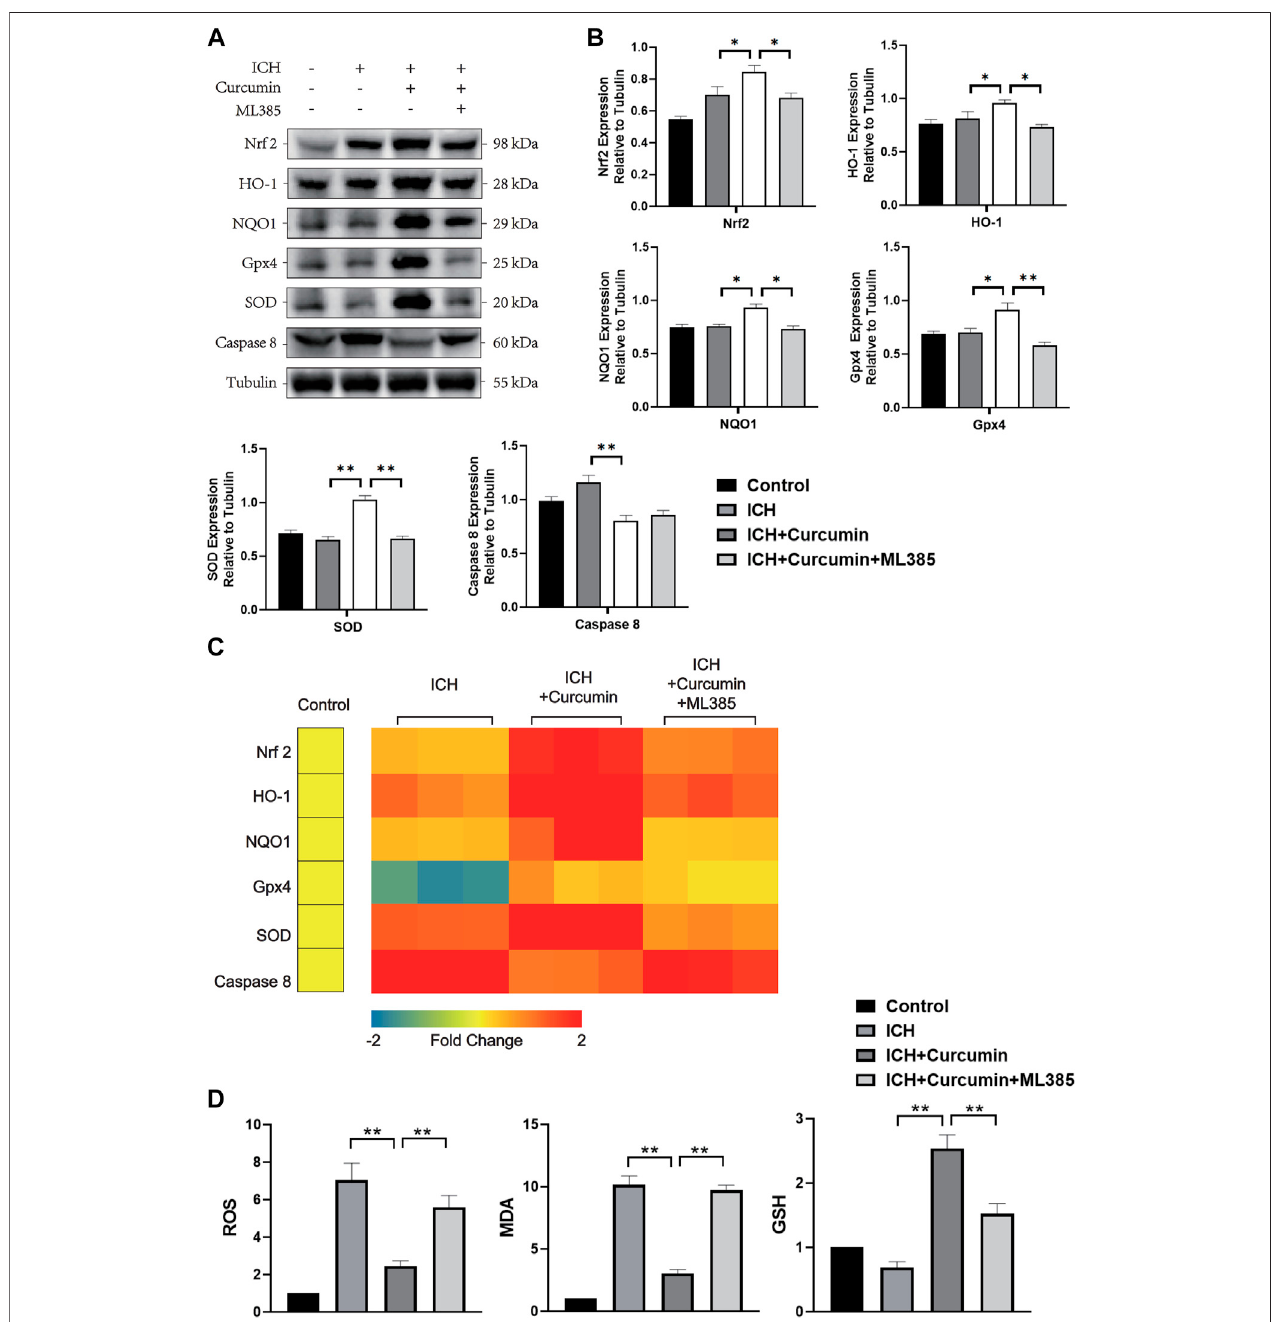
FIGURE 7 | In vivo experiments were performed to evaluate the function of curcumin activation of the Nrf2/HO-1 pathway. (A) The western blot analysis of Nrf2, HO-1, NQO1, Gpx4, SOD, and Caspase8 in the surrounding tissues of hematoma at 7 d after ICH. (B) ImageJ software was used to further quantify the gray values of Westernblotbands. (C) HeatmapofthemRNAabundanceofgenesintheNrf2signalingpathway,includingNrf2,HO-1,NQO1,Gpx4,SOD,andCaspase8. (D) Thekit was used to detect the MDA, ROS, and GSH content in each group of the surrounding tissues of hematoma (the speci fi c detection method has been described in detail above). Data are shown as the means ± SD of n = 3 samples/group and at least three independent experiments were performed. The statistical analyses were conducted using the two-way ANOVA. *, p < 0.01 and **, p < 0.01.